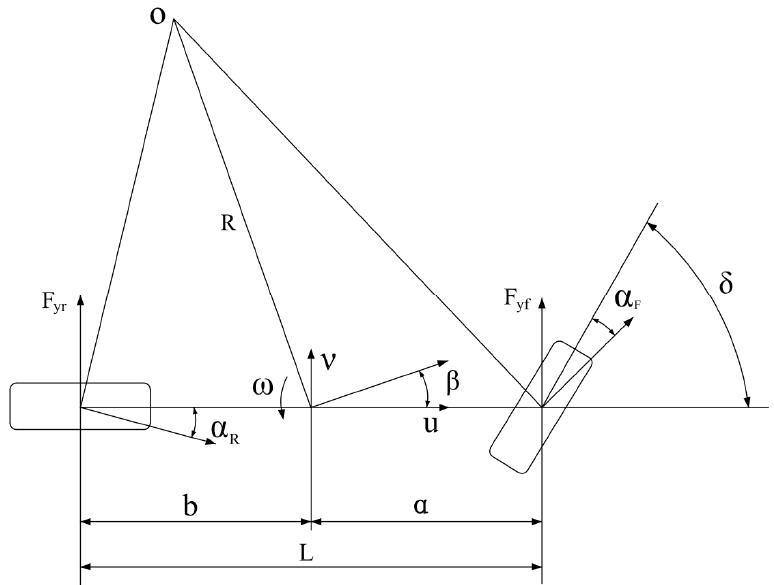
Figure 6. The 2-DOF vehicle model .